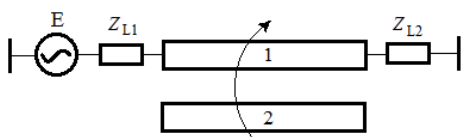
Fig. 1. Split strip line segment, in which the second strip is not loaded.